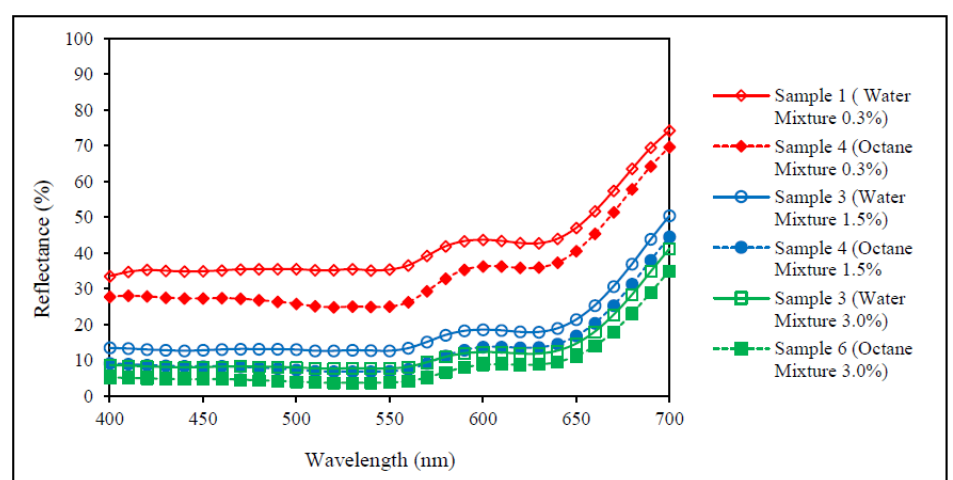
Figure 5. Reflectance curves of blue colour.